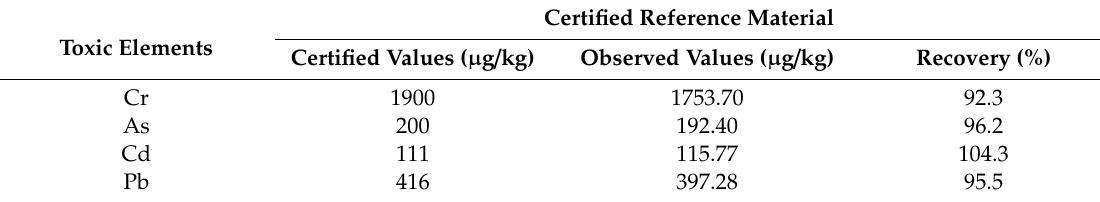
Table 3. Quality control of certified reference material, milk